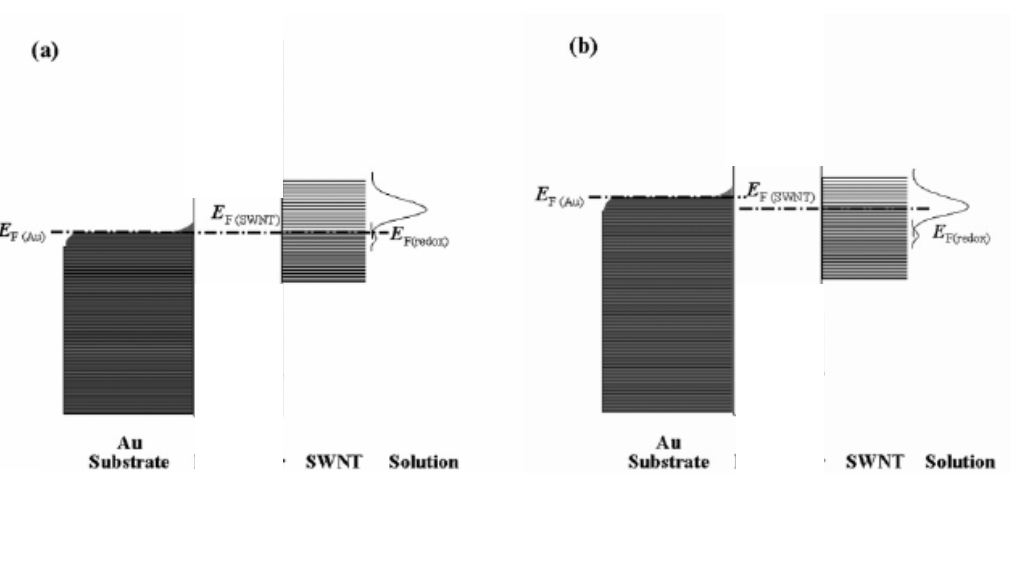
Figure 7. The variation of peak separation with scan rate. The electrolyte used was a 1mM solution of ferricyanide in 50 mM KCl in a 50 mM Phosphate buffer solution (pH 7) (adapted from